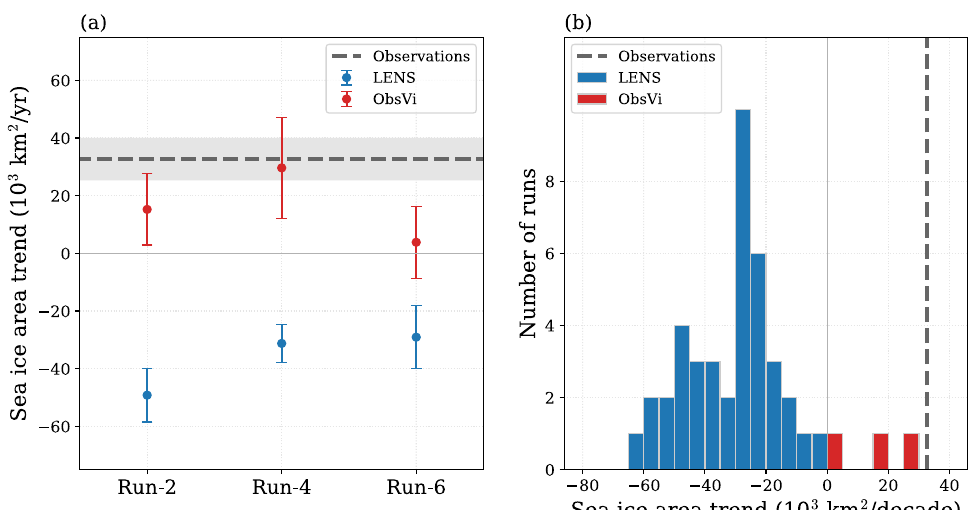
Fig. 2 Antarctic sea ice area trend. a Linear trend in the annual-mean sea ice area during 1992 – 2015 in the observations (gray dashed line) and the LENS (blue dots) and ObsVi (red dots) simulations. The error bars show the standard error associated with the linear trends, which are calculated using ordinary least squares regression. b Histogram of the linear trends in annual-mean sea ice area for the 40 CESM LENS runs (blue) and the three ObsVi runs (red), along with the linear trend in the observations (gray dashed line). Note that the result is approximately equivalent when ice extent is used rather than ice area (see Supplementary Fig. 4).